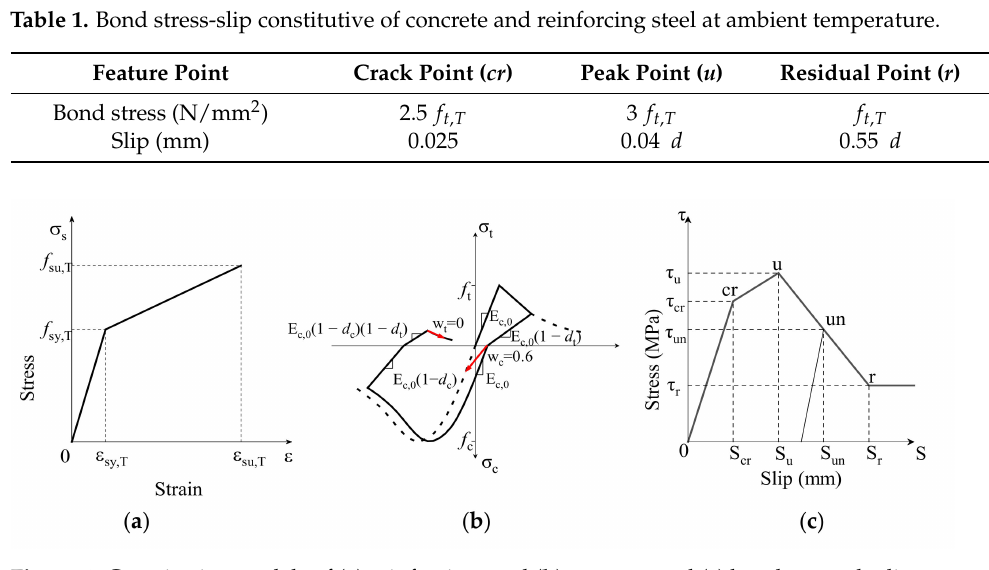
Figure 4. Constitutive models of ( a ) reinforcing steel ( b ) concrete and ( c ) bond strength-slip.